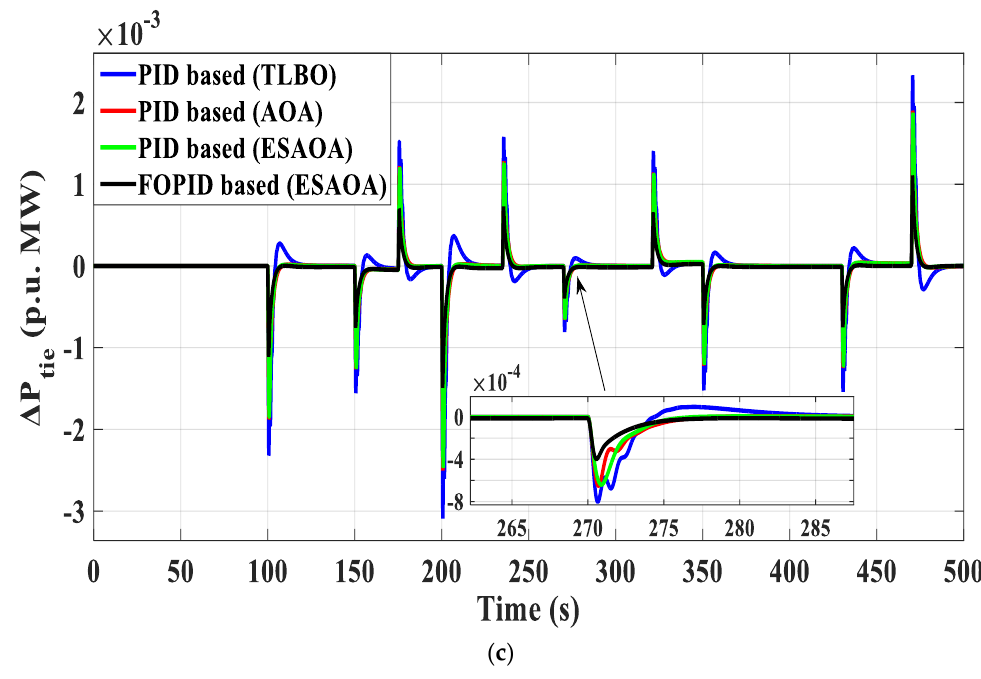
Figure 19. Dynamic system response of scenario A with random load variation at the first area ( a ) ∆ f 1 , ( b ) ∆ f 2 , and ( c ) ∆ p tie .